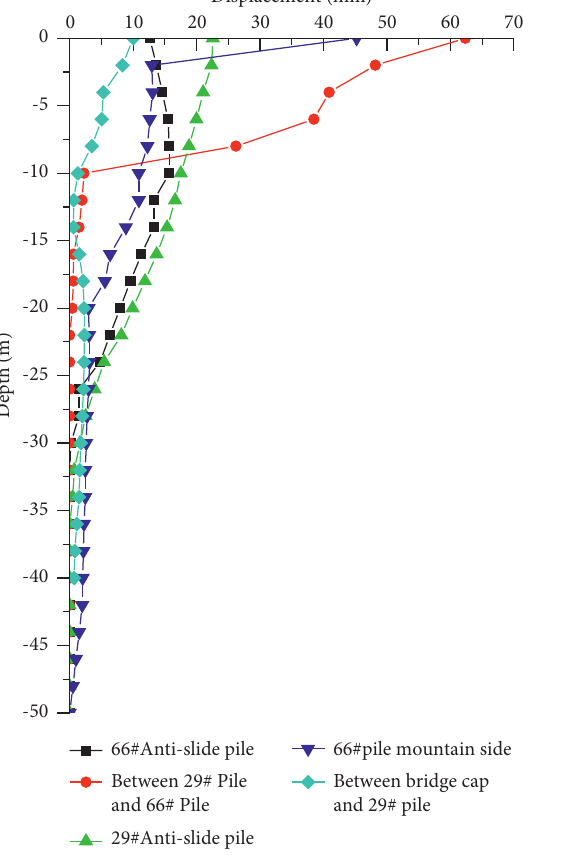
Figure 14: The deep displacement curve of the slope.